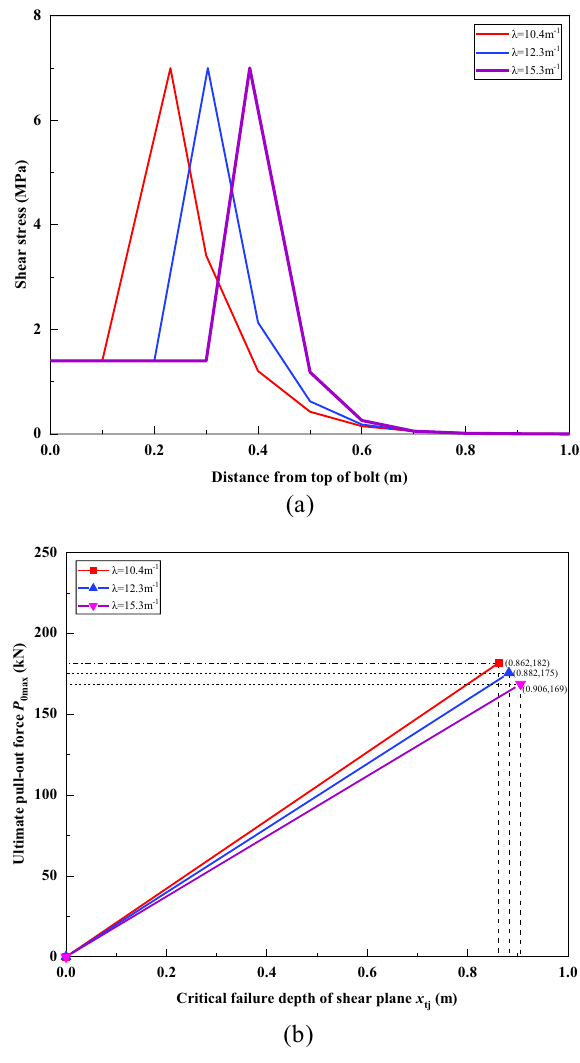
Figure 24. Effect of parameter λ . ( a ) When α = 0.2, the effect of different λ on shear stress distribution under 100 kN load; ( b ) The influence of different λ on the ultimate pull-out force of the